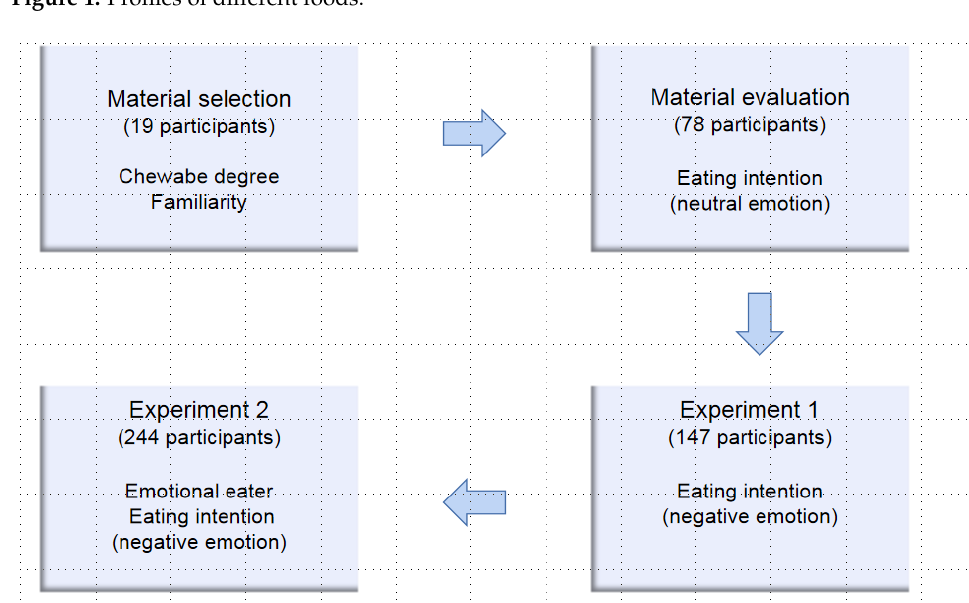
Figure 2. Diagrammatic representation of each experiment. Table 1. Mean scores of different foods on chewiness degree and familiarity.